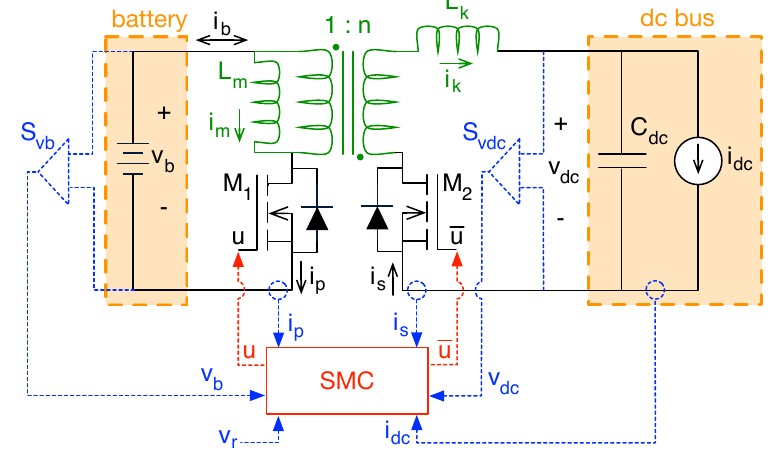
Figure 2. Proposed circuit for the charger/discharger based on the flyback